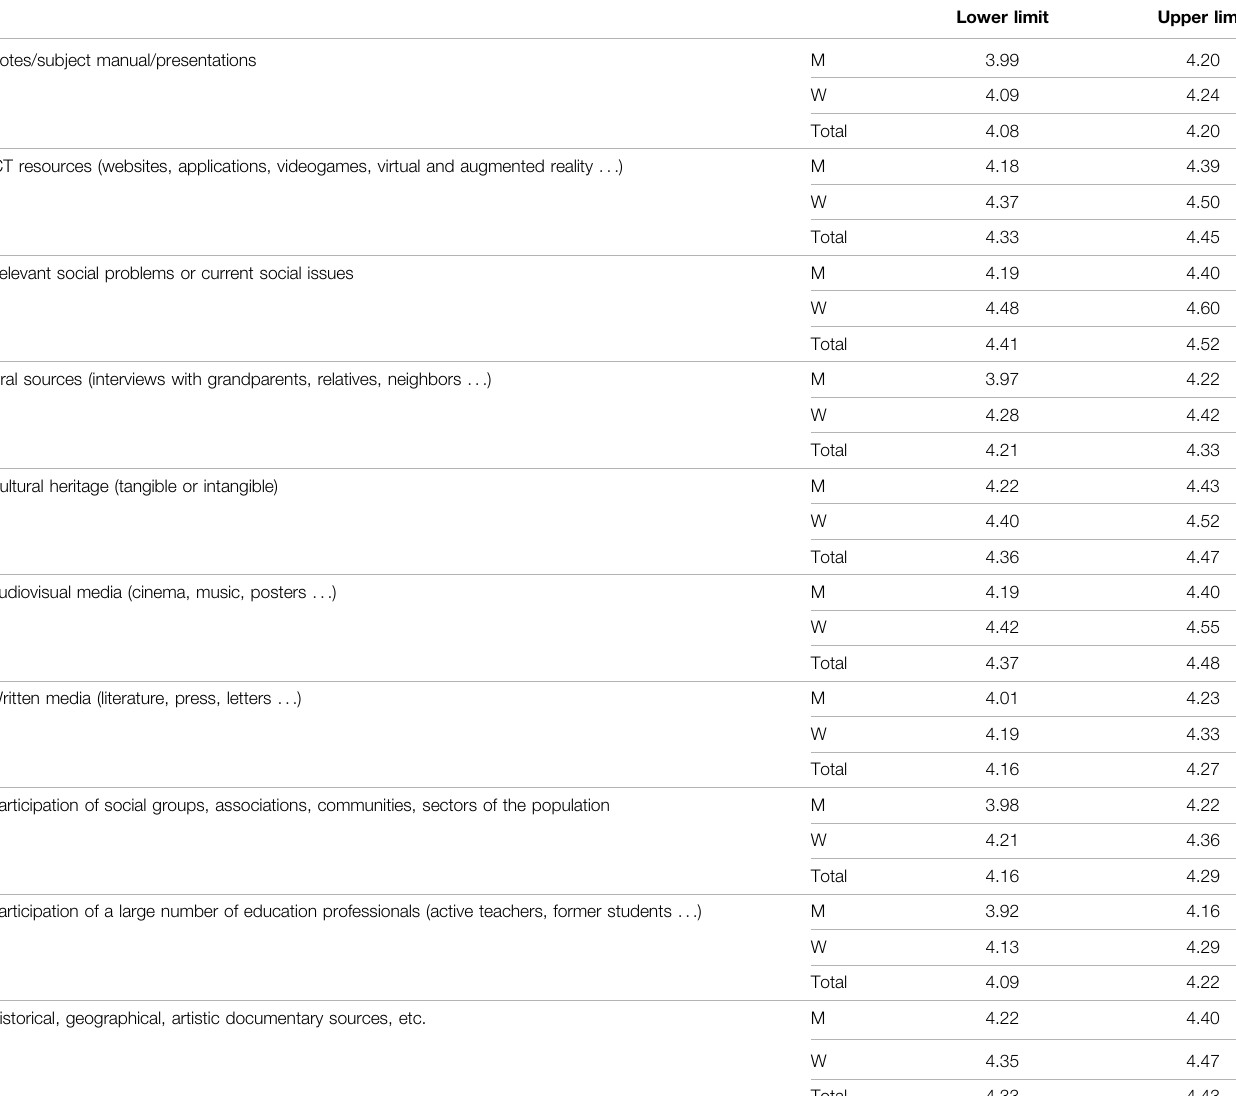
TABLE 6 | Descriptive analysis of the teaching resources, according to